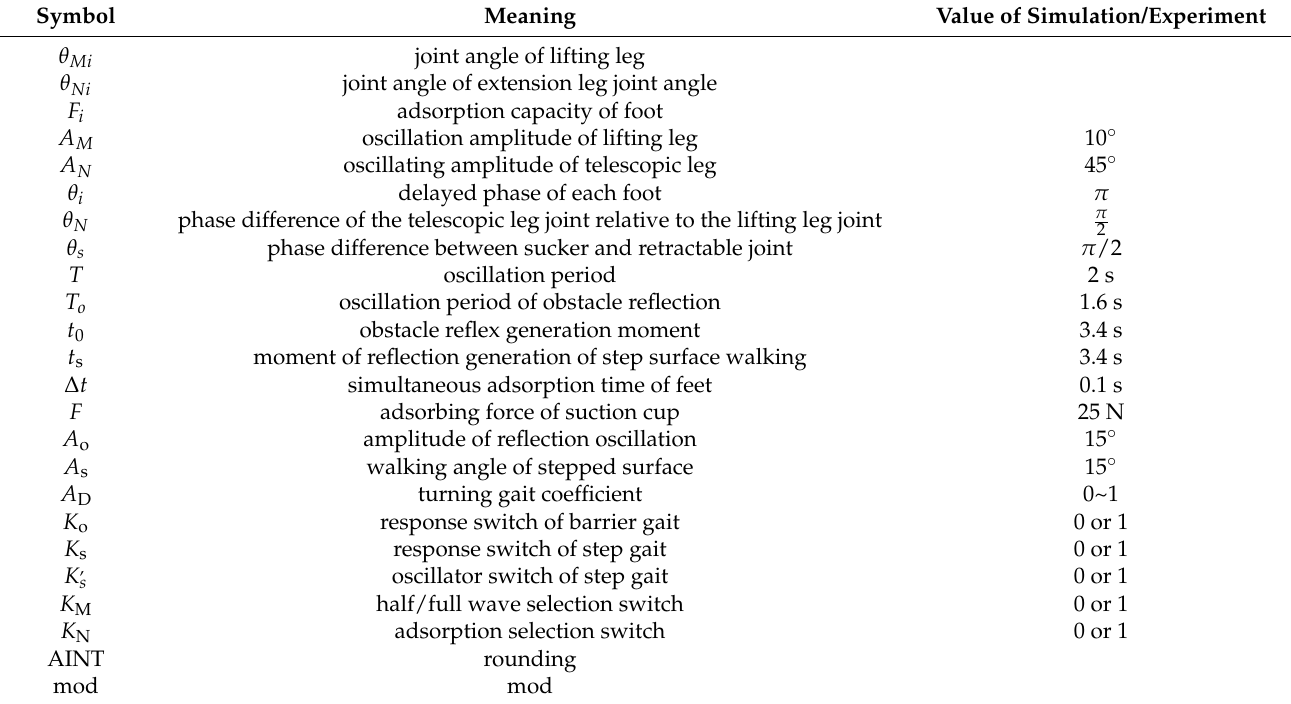
Table 2. Definitions and values of the parameters of the CPG